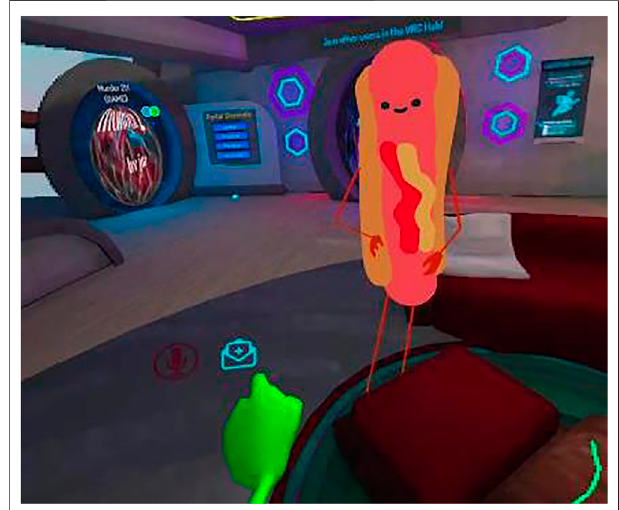
FIGURE 4 | Noti fi cation icon in